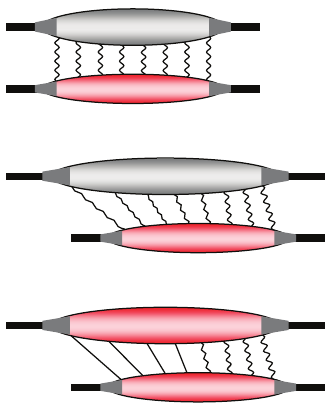
Figure 4: Drawings to illustrate length changes of connective tissue linkages between passive (grey) and active (red) synergistic muscles. Changing the length of one muscle results in reorientation as well as unfolding of those linkages. Unfolding is also seen with coactivation. Such straightening of macroscopic crimp in collagen fibrils is correlated to the toe region of the stress-strain curve [35]. Modified from Maas and Sandercock